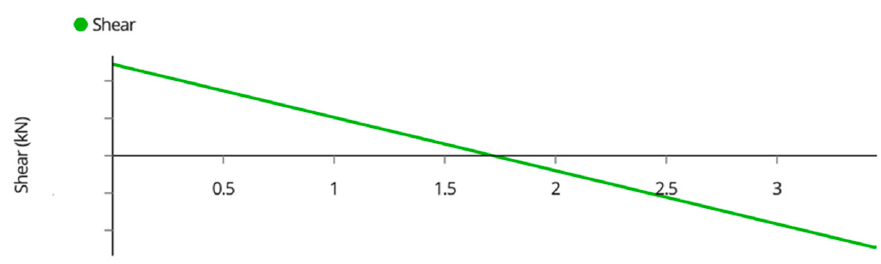
Figure A1. The 2 × 4 Wind Load Free-Body Diagram. The shear force diagram of each 2 × 4 is seen as in Figure A2.